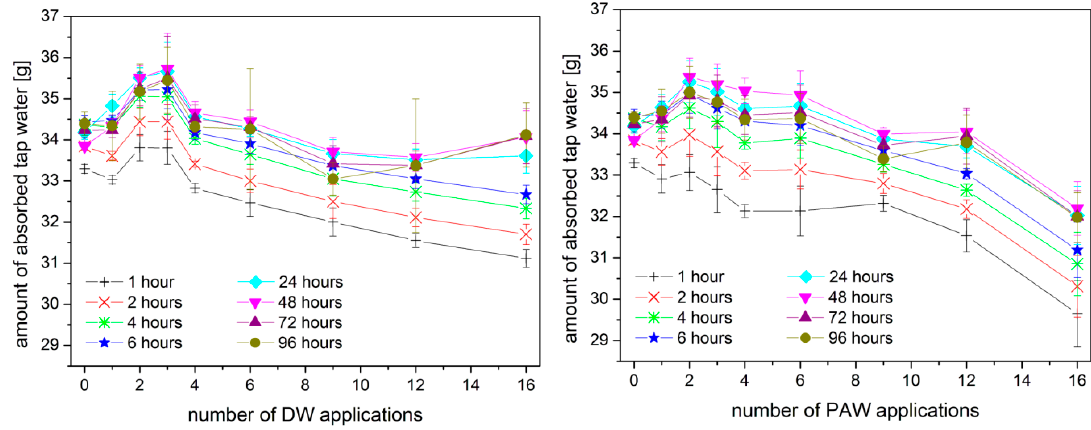
Figure 5. Absorption of tap water in dependence on the number of DW/PAW applications. Water 2020 , 12 , x FOR PEER REVIEW